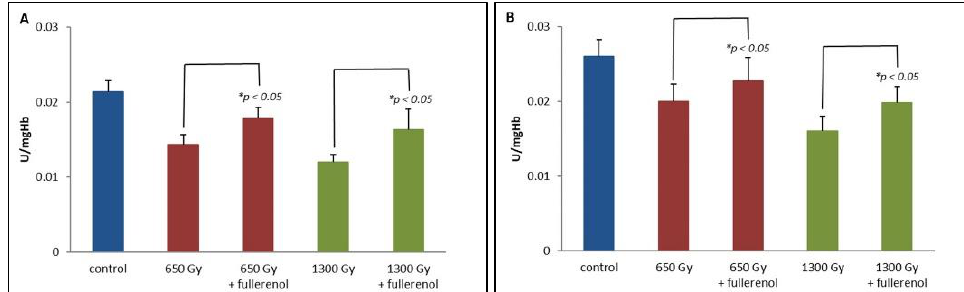
Figure 2. ( A ) The effect of fullerenol on glutathione peroxidase (GPx) activity. Fullerenol at a con- centration of 150 µg/mL was added to the erythrocyte suspension 1 h before irradiation with doses of 650 and 1300 Gy. Measurements were taken 2 h after irradiation and haemolysis. Bars represent mean values ± SD for 3 independent measurements. ( B ) The effect of fullerenol on glutathione re- ductase ( GSR) activity. Fullerenol at a concentration of 150 µg/mL was added to the erythrocyte suspension 1 h before irradiation with doses of 650 or 1300 Gy. Measurements were taken 2 h after irradiation and haemolysis. * Statistically significant values at p < 0.05. We also measured the effect of fullerenol for glutathione reductase (GSR) activity. GSR activity in the RBC suspension incubated with 150 µ g/mL of C 60 (OH) 36 and subjected to irradiation of 650 or 1300 Gy is presented in Figure 2B. A decrease in GSR activity after 2 h from irradiation is statistically significant, and the changes are proportional to the dose (with respect to controls for p < 0.05). For the irradiated samples containing C 60 (OH) 36 , we